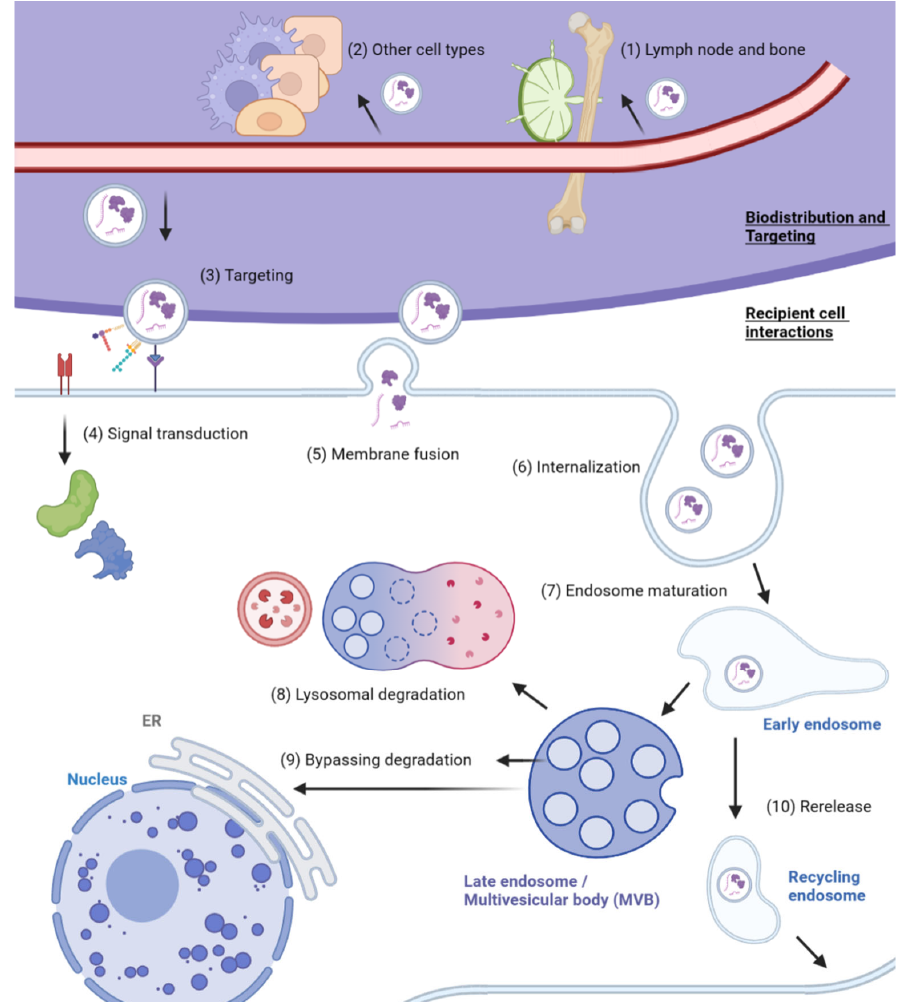
Figure 3. Overview of exosome biodistribution and uptake. The biodistribution of secreted exosomes is affected by (1) retention in lymph nodes and bone tissue and (2) competition from other cell types that vary in the rate of exosome uptake. Exosomes can be (3) targeted to recipient cells by receptor–ligand interaction, the presence of complex lipids on the exosome membrane, and recog- nition moieties from the donor cell type. Exosomes exert their functions in three ways—(4) activat- ing signal transduction by receptor–ligand binding, (5) membrane fusion to release contents and (6) internalization via endocytic pathways. (7) Endosomes containing internalized exosomes eventually mature into multivesicular bodies (MVBs) and (8) undergo lysosomal degradation together with the exosomes. (9) Exosomal cargo may bypass degradation by passive di ff usion, activation by acidi fi ca- tion, RNA transfer to endoplasmic reticulum (ER) or release into the cytosol by exosome fusion with the endosomal membrane. (10) Internalized exosomes can also be re-released from early endosomes into the extracellular space via recycling endosomes.